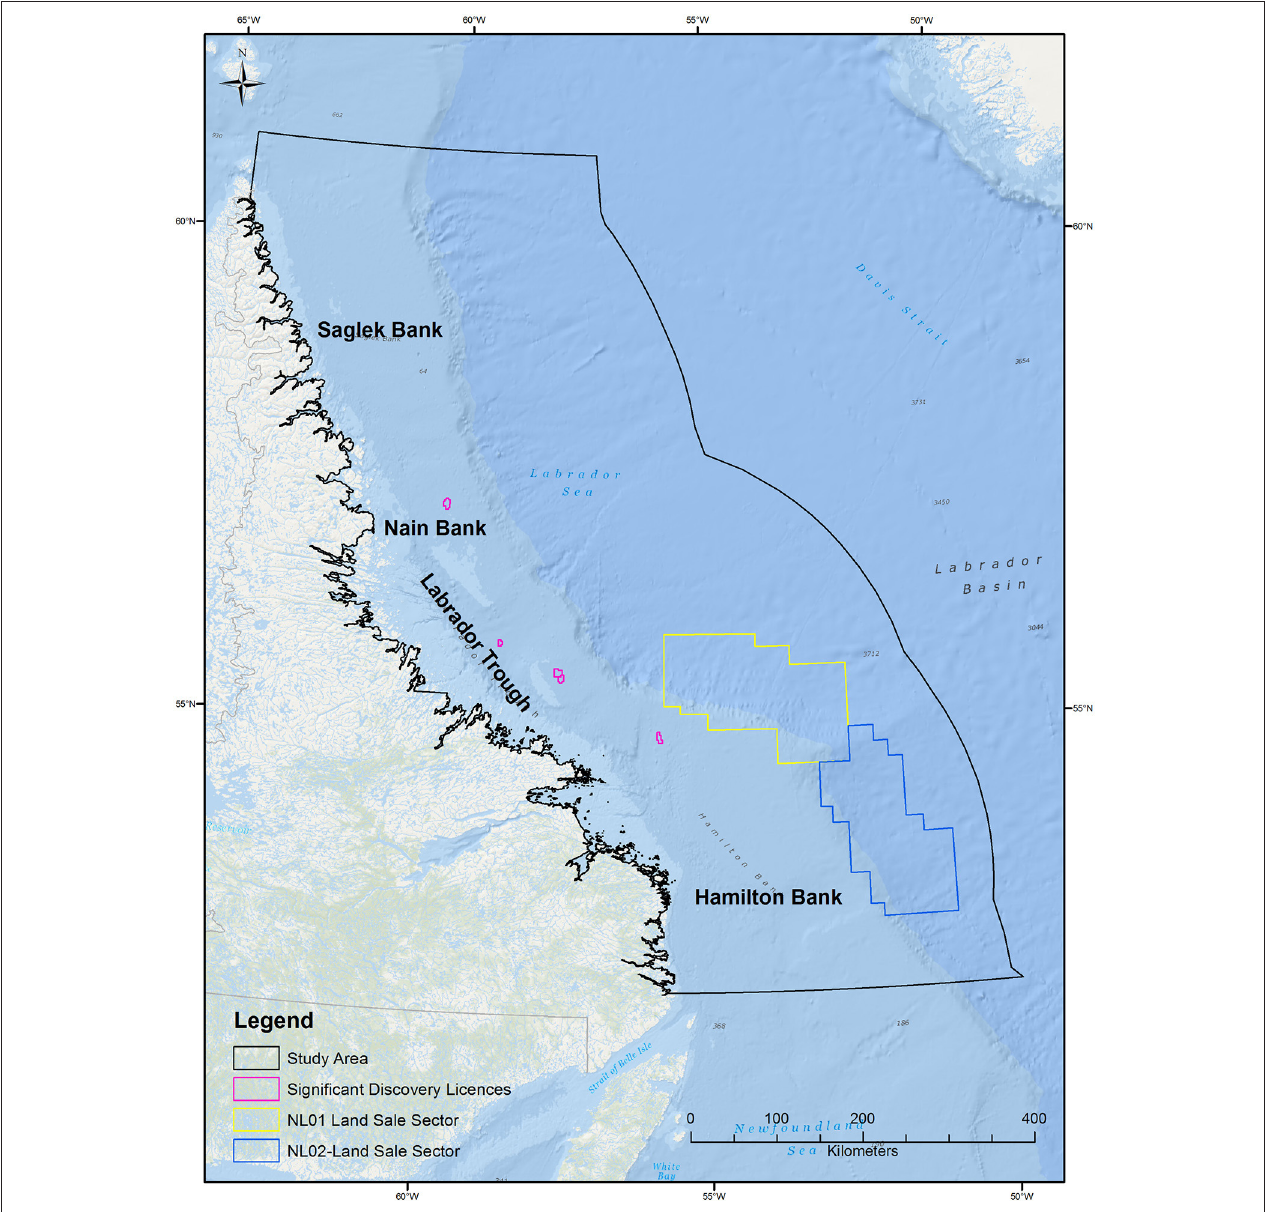
FIGURE 1 | Labrador Sea study area, which encompasses the area of the Labrador Sea delineated by NAFO regions 2G, 2H, 2J, out to the Canadian EEZ (Exclusive Economic Zone). Significant discovery licenses and active C-NLOPB land issuance sectors in the Labrador Sea are also